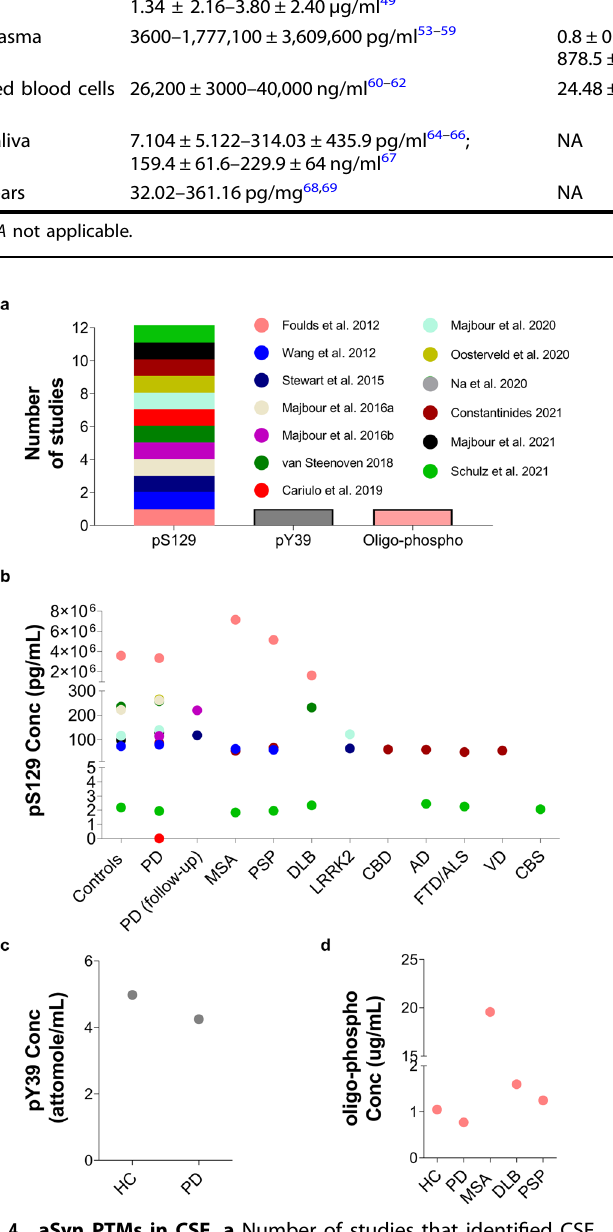
Fig. 4 aSyn PTMs in CSF. a Number of studies that identi fi ed CSF aSyn PTMs. b Variability of pS129 levels across the different disease groups and controls. Each dot in the graph corresponds to the average values of pS129 aSyn reported in the respective study. Other aSyn PTMs, i.e., c Levels of pY39 and d oligo-phosphorylation reported in single studies. The legend/color code in a corresponds also to b , c and d